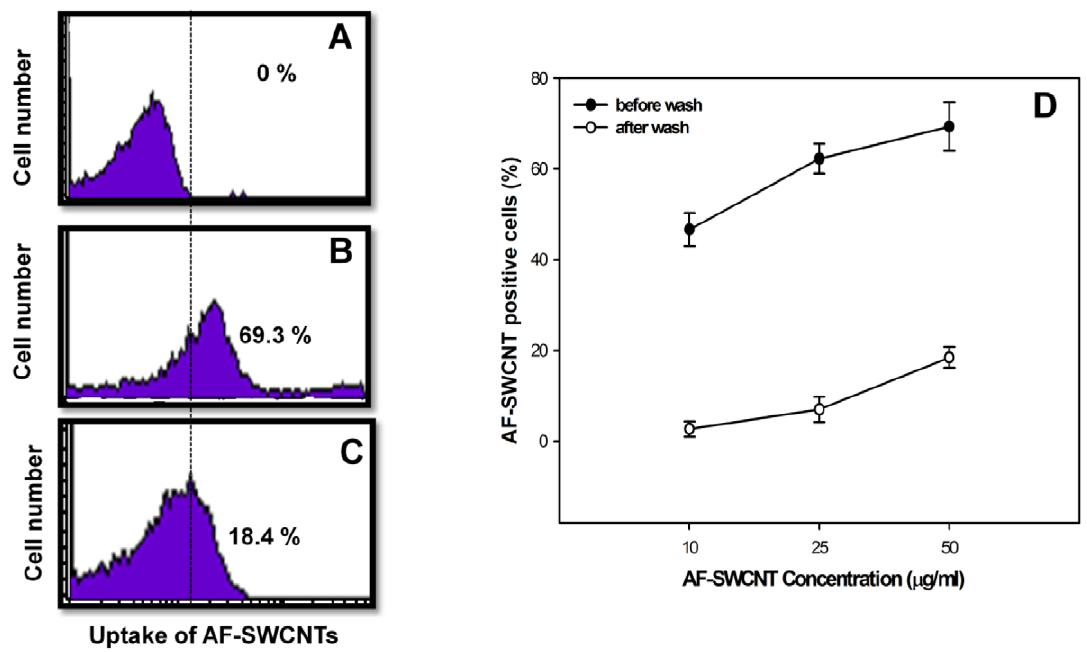
Figure 2. Uptake of fluorescenated AF-SWCNTs by erythrocytes invitro . Erythrocytes were incubated with fluorescenated AF-SWCNTs (50 m g/ml) for 1 h and examined flow cytometrically either before (panel B) or after (panel C) three washings with fresh medium. Panel A shows the flow histogram for control unstained erythrocytes. Panel D shows the dose dependent uptake of AF-SWCNTs by erythrocytes with or without three washings. Results of a representative experiment have been shown. In panel D all data points represent mean 6 SEM of three observations.